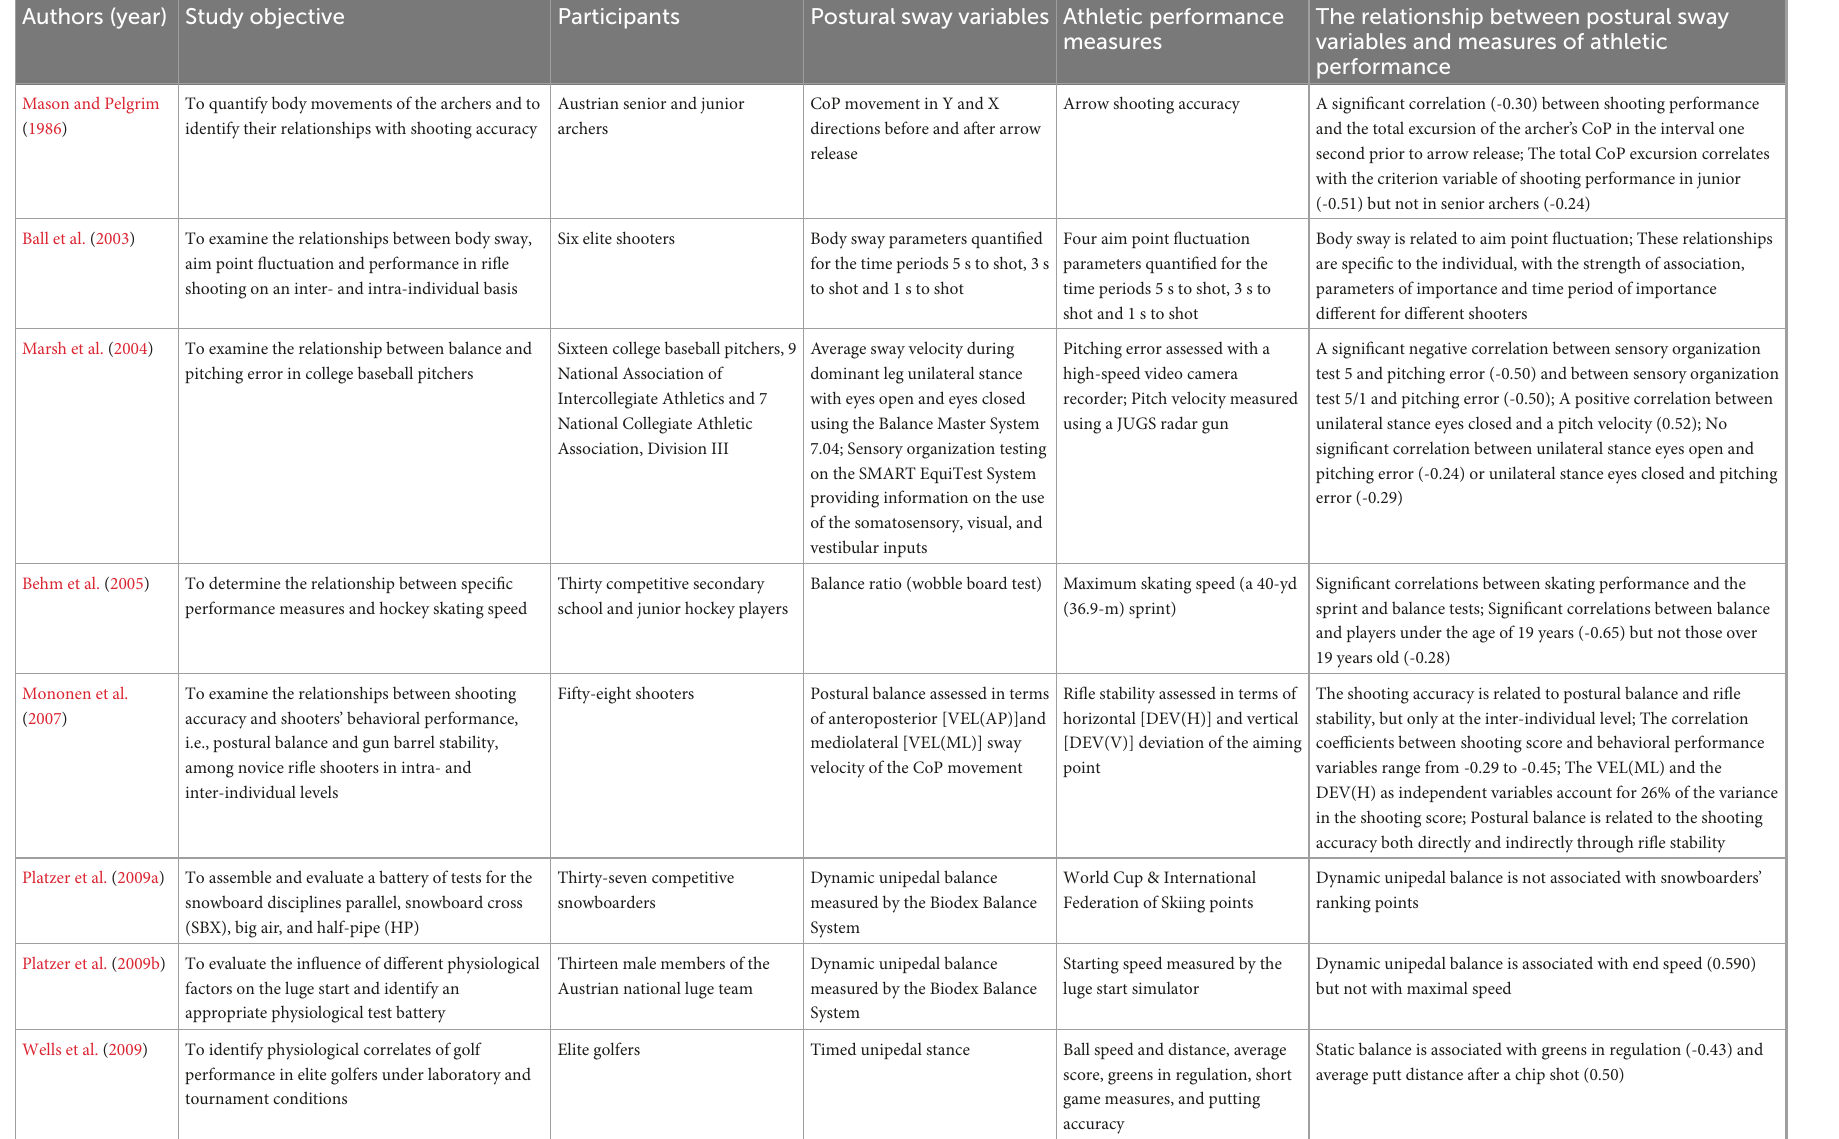
TABLE 1 An overview of studies dealing with the relationship between postural sway variables and measures of athletic performance. Authors (year) Study